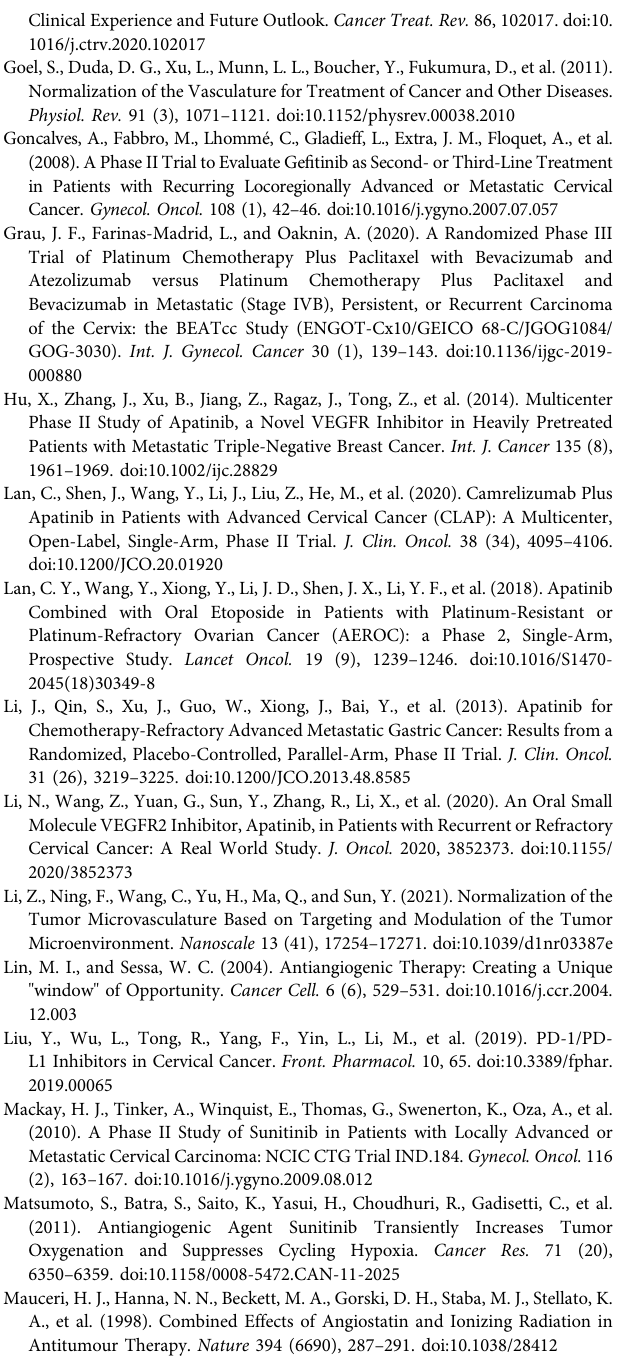
sensitivity analysis for PFS; (E) sensitivity analysis for hand – foot syndrome; (F) sensitivity analysis for hypertension; (G) sensitivity analysis for proteinuria; (H) sensitivity analysis for fatigue; (I) sensitivity analysis for hemorrhage; (J) sensitivity analysis for thrombocytopenia; (K) sensitivity analysis for diarrhea and nausea; and (L) sensitivity analysis for neutropenia. ORR, objective response rate; DCR, disease control rate; OS, overall survival; PFS, progression-free